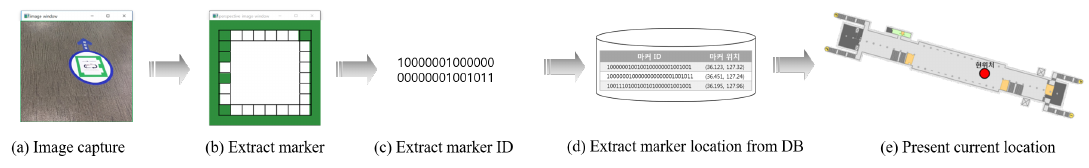
Figure 5. Marker recognition process for